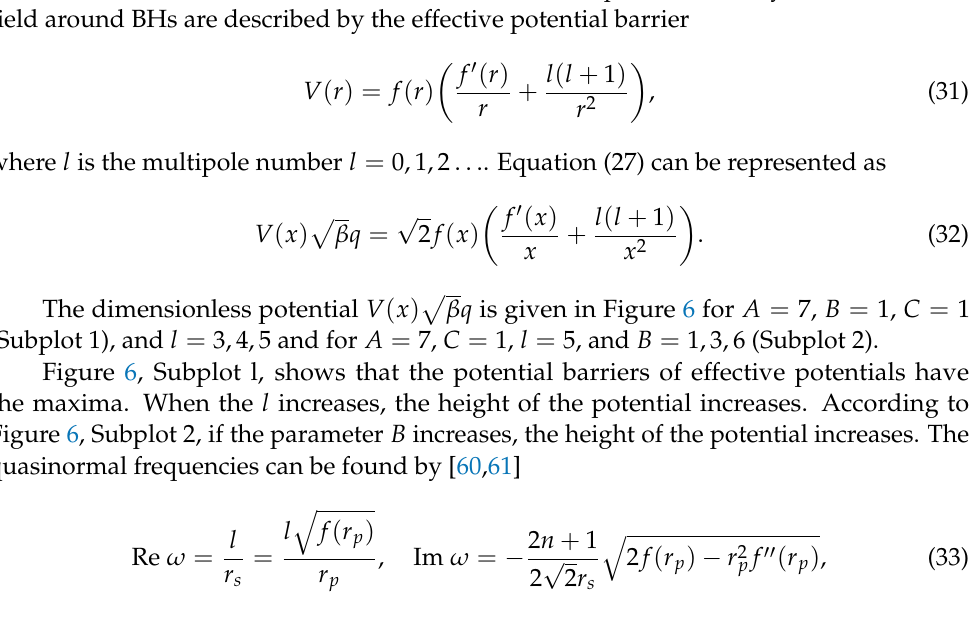
√ 2 E ( ω ) q d vs. (cid:118) for B = 0.1,3,6, A = 7, C = dtd ω